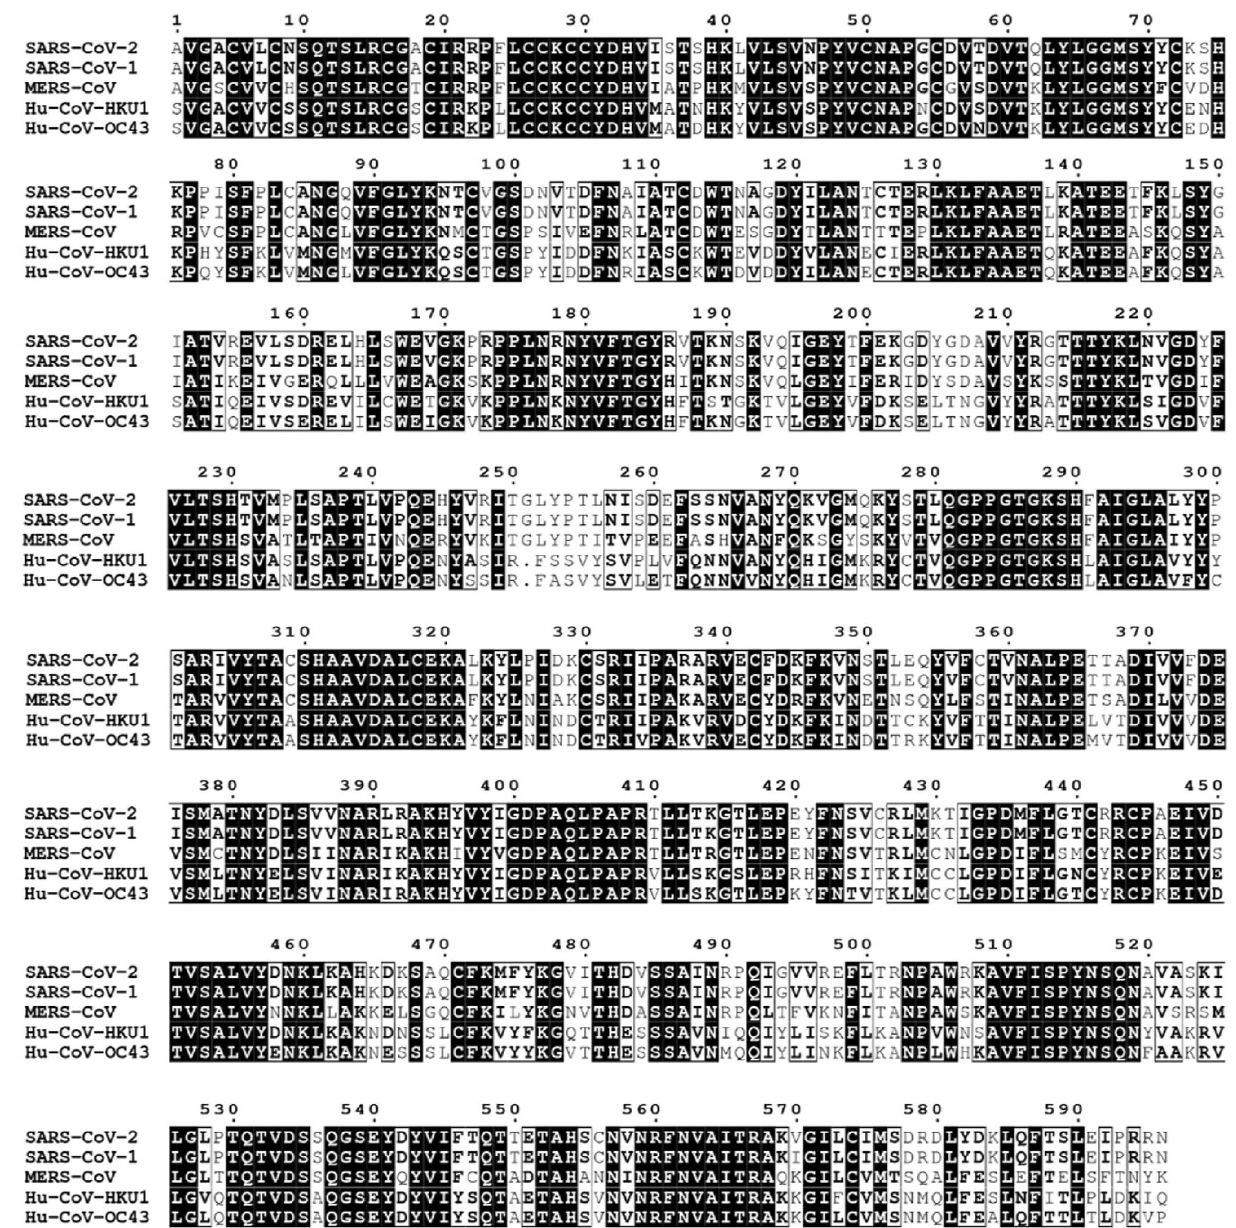
Figure 7. Sequence alignment of known human coronaviruses sharing helicase domain architecture: Multiple sequence alignment (ranging from amino acid 3–596, numbered according to their position in the helicase protein) was performed employing ‘Clustal W’. Conserved residues/sites are highlighted in black color, residues conserved in two or more sequences are shown in black font, while differences are shown in grey font. Publication quality alignment was prepared using the ENDscript server 45